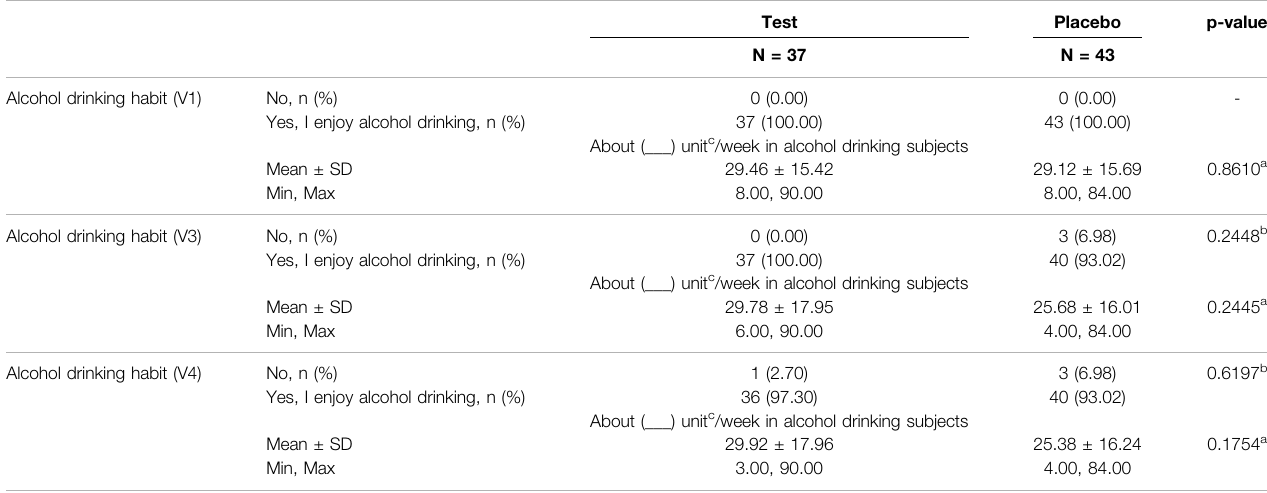
TABLE 3 | Questionnaire on alcohol drinking habit (PP Set).